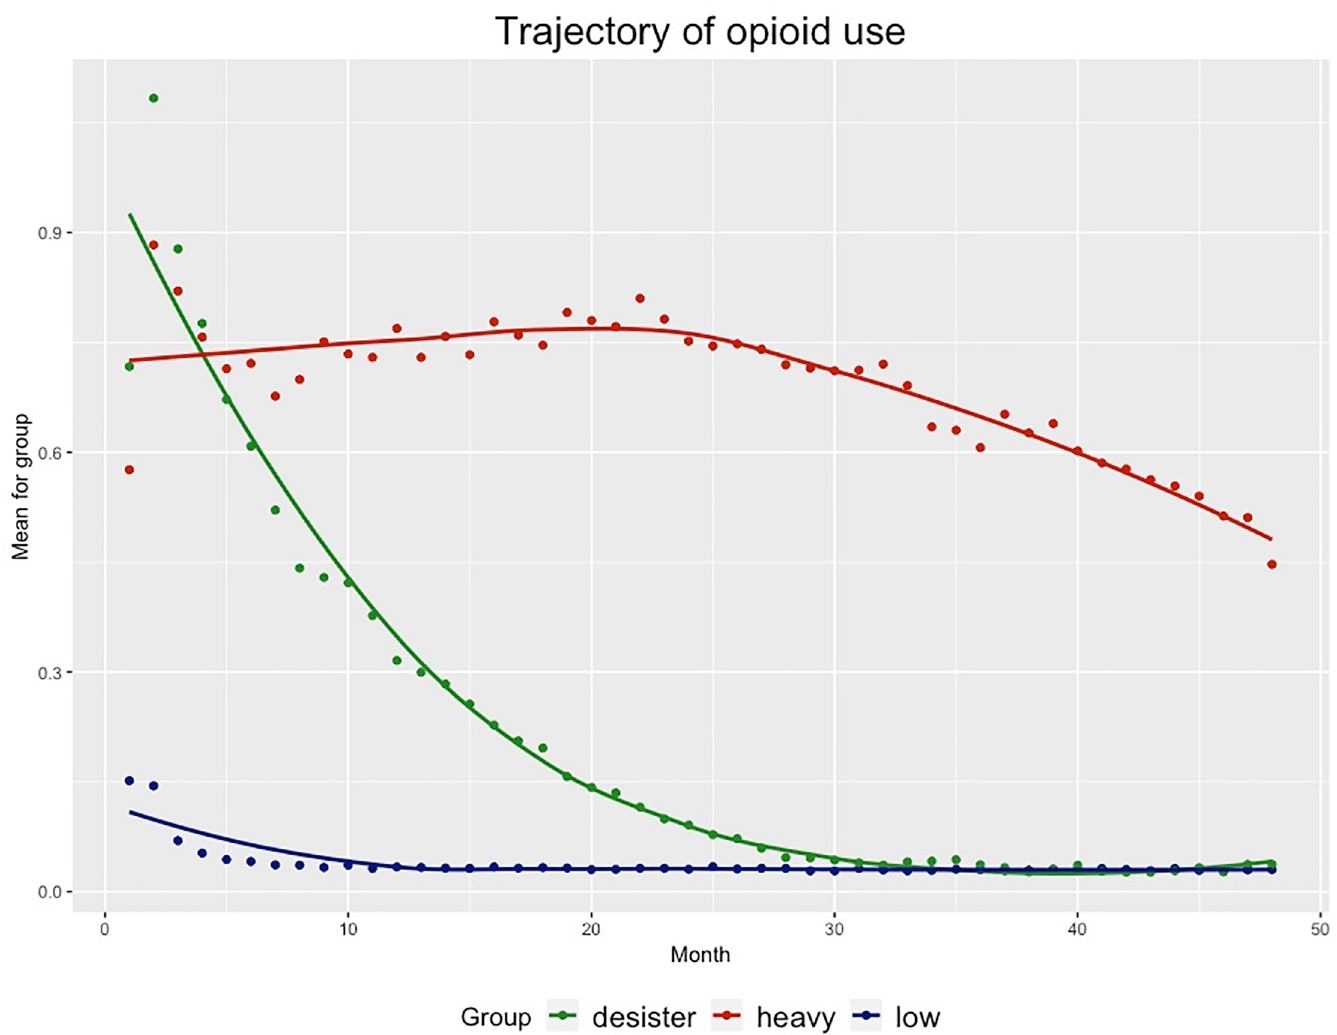
Fig 1. Trajectories of prescription opioid use over a two-year period after the index prescription, modeled in training data from 2010–2011.